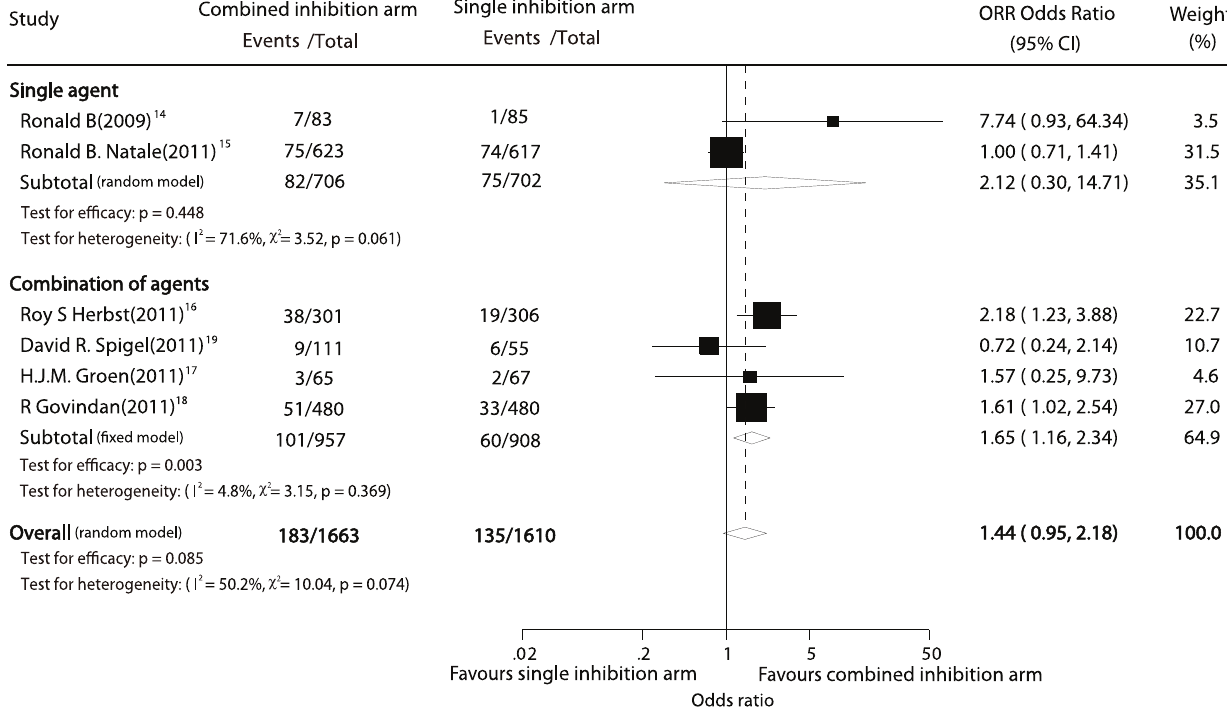
Figure 4. Comparison of objective tumor response rate between combined inhibition therapy and single inhibition therapy.